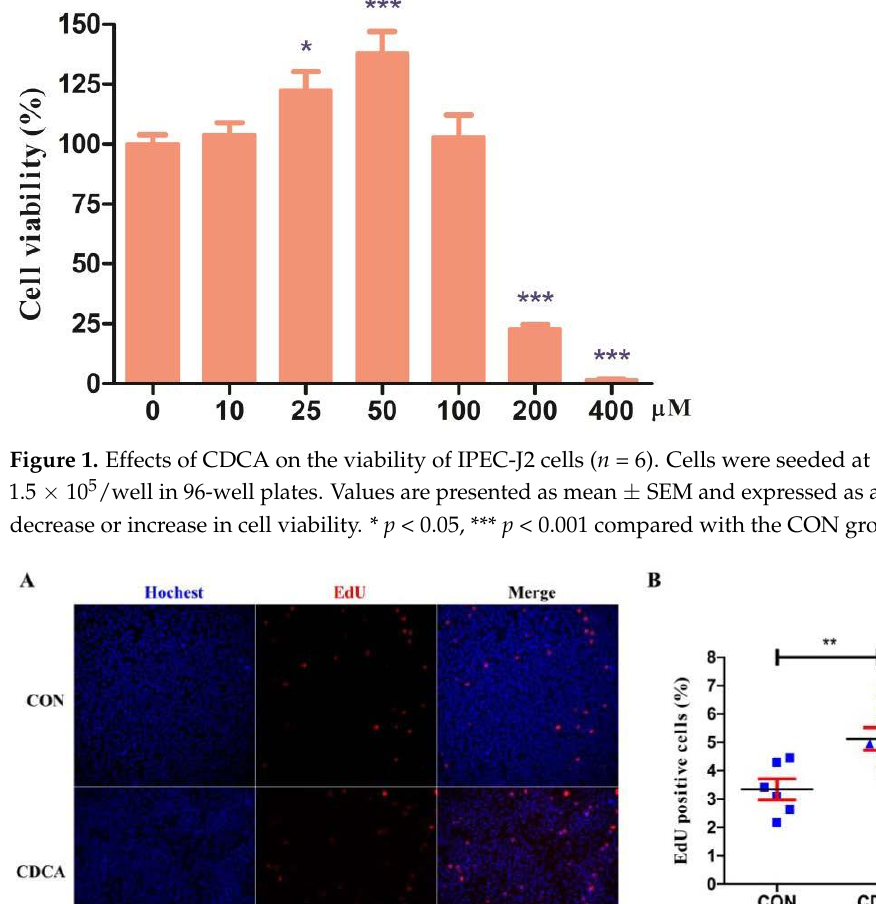
Figure 1. Effects of CDCA on the viability of IPEC-J2 cells ( n = 6). Cells were seeded at a density of